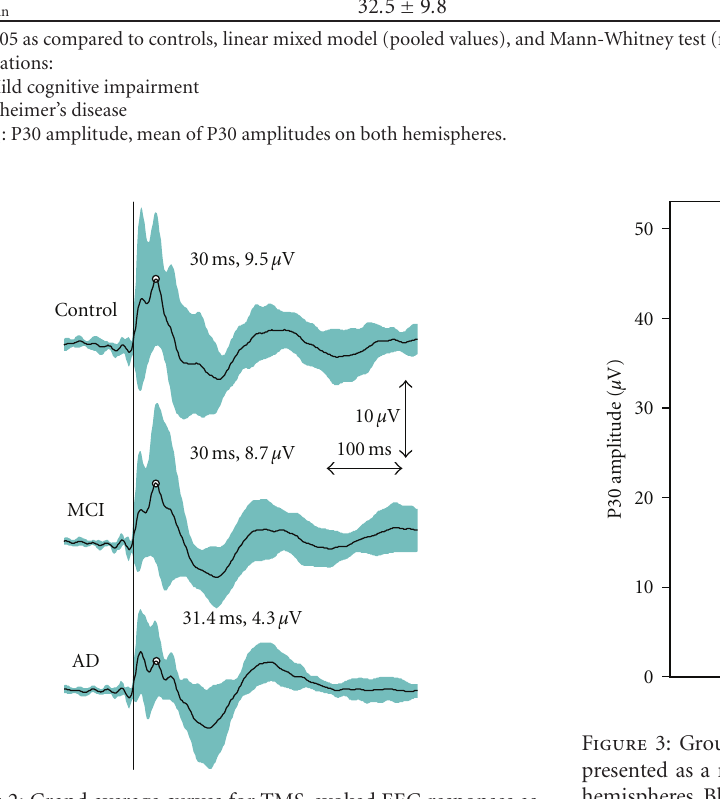
Figure 2: Grand average curves for TMS-evoked EEG responses as measured from the central electrode (CZ). The mean peak for the P30 has been indicated. However, P30 was analyzed for individuals from the electrode chosen based on the shortest latency and clearest identification on the stimulated hemisphere. The turquoise area represents the 95% confidence interval for the TMS-EEG responses. The vertical black line indicates the moment of stimulation.